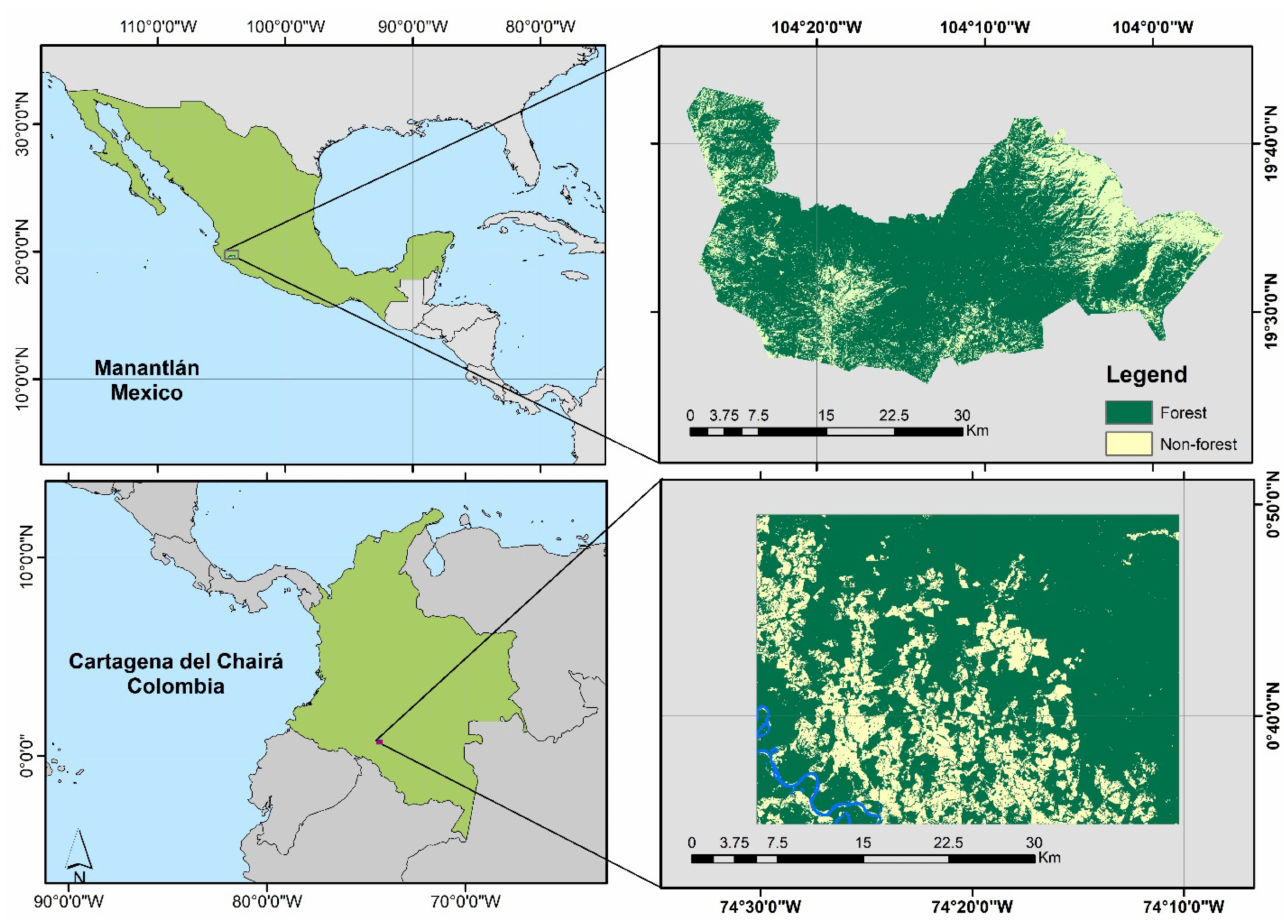
Figure 2. The window areas of Manantl á n (Mexico) and Cartagena del Chair á